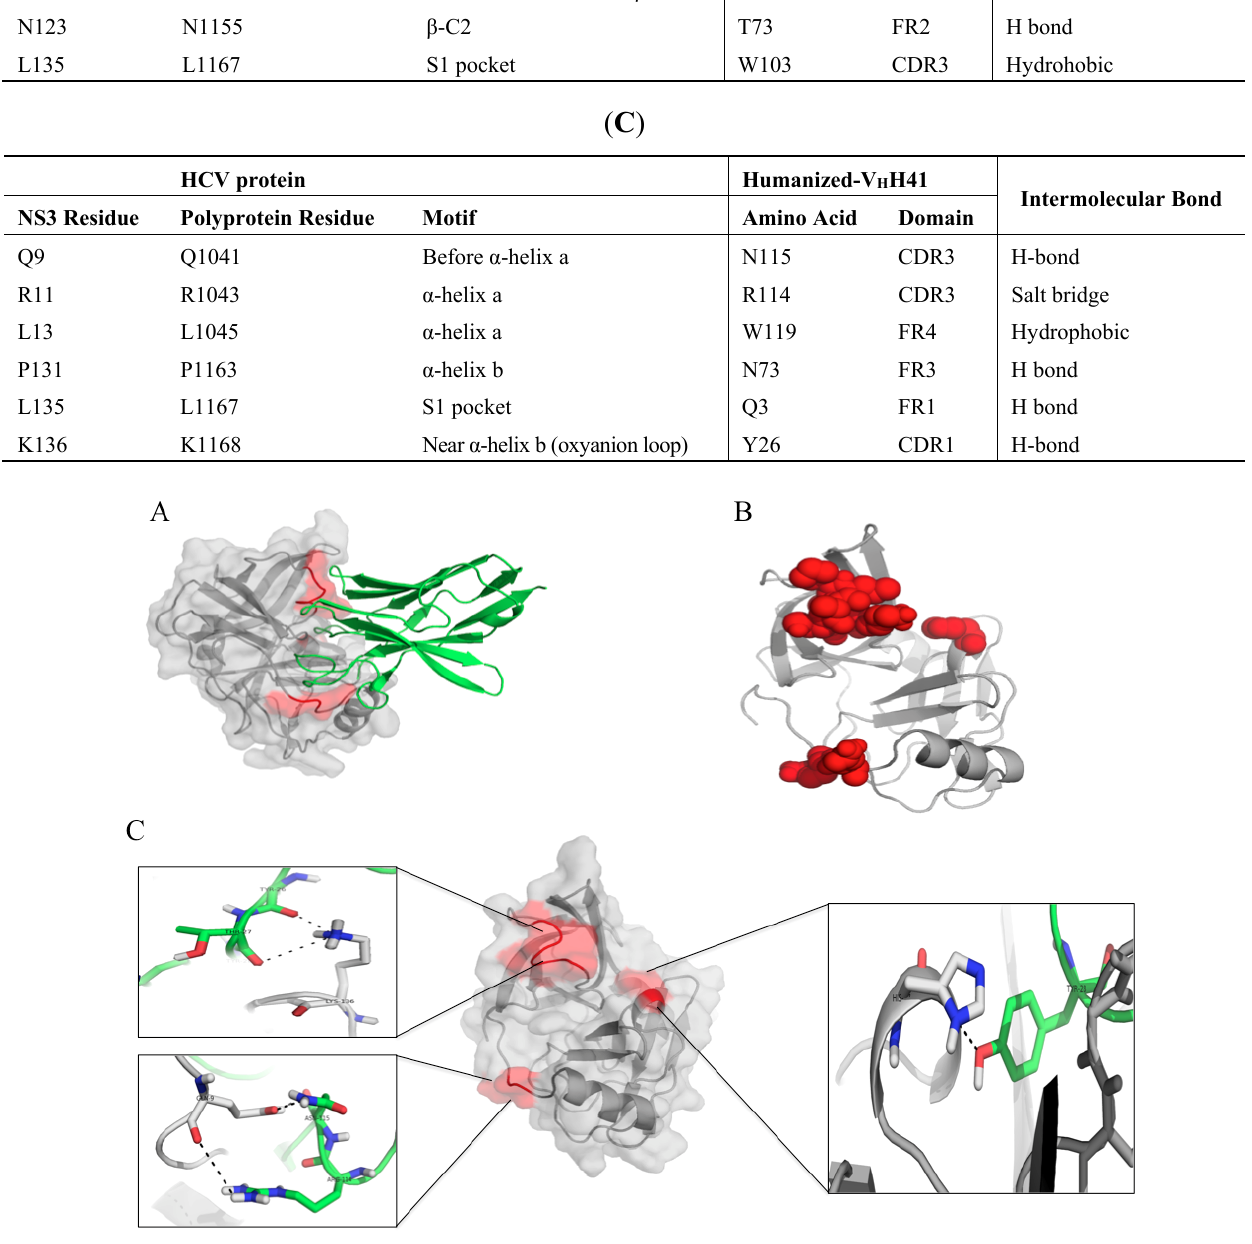
Figure 11. The interactive residues between the HCV NS3/4A protease and the protease specific-V H H41. ( A ) and ( B ) The nanobody (green in A) uses CDRs 1 and 3 and FRs 1, 3 and 4 to bind to juxtaposed areas of the folded protease molecule (red); ( C ) Details of the interactive residues between the nanobody (green) and the target (grey) (see also Table